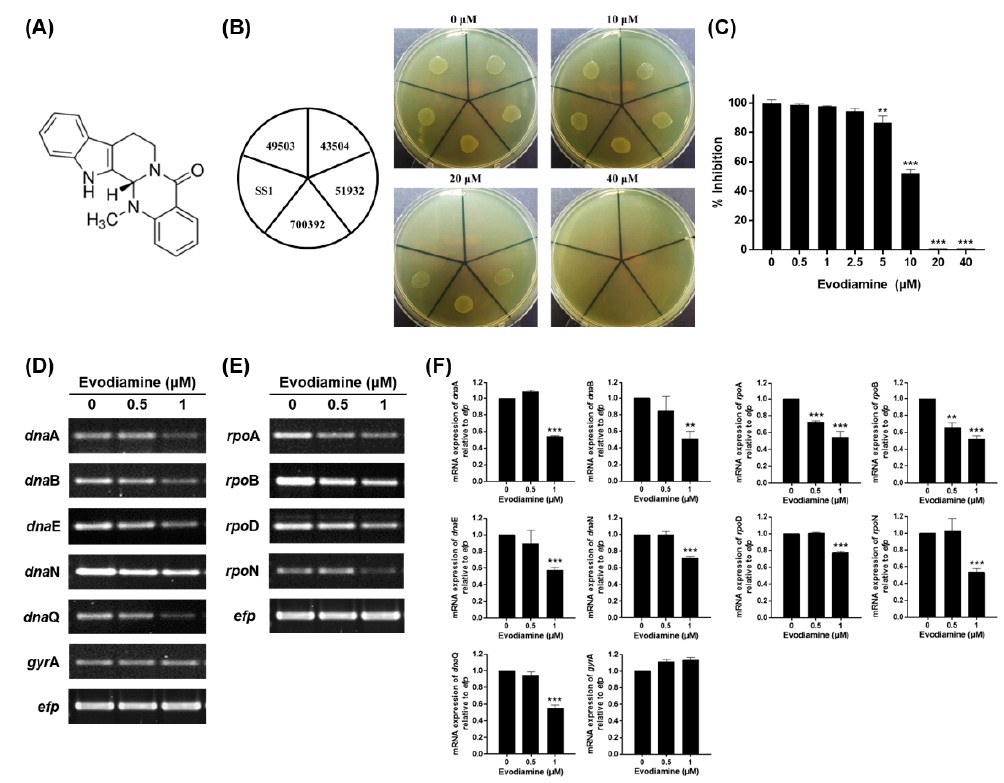
Figure 1. Anti-bacterial activity of evodiamine against H. pylori and downregulation of replication and transcription genes of H. pylori . ( A ) Chemical structure of evodiamine. ( B ) The MIC of evodiamine against five H. pylori reference strains (ATCC 49503, ATCC 43504, ATCC 51932, ATCC 700392 and SS1) was determined by agar dilution method. ( C ) The MIC of evodiamine against H. pylori ATCC 49503 strain was confirmed by broth dilution method. Optical density of bacterial broth was measured at 600 nm wavelength by spectrophotometry. H. pylori was treated with indicated concentrations of evodiamine (0.5 and 1 μ M) for 72 h. RNA was subjected to RT-PCR to detect the mRNA expression levels of ( D ) replication machineries ( dna A, dna B, dna E, dna N, dna Q and gyr A) and ( E ) transcription machineries ( rpo A, rpo B, rpo D and rpo N). The expression of efp was used as an internal control. ( F ) Each band intensity was normalized to efp . Data are presented as mean ± SEM of three independent experiments and analyzed by Student’s t -test (** p < 0.01 and *** p < 0.001).